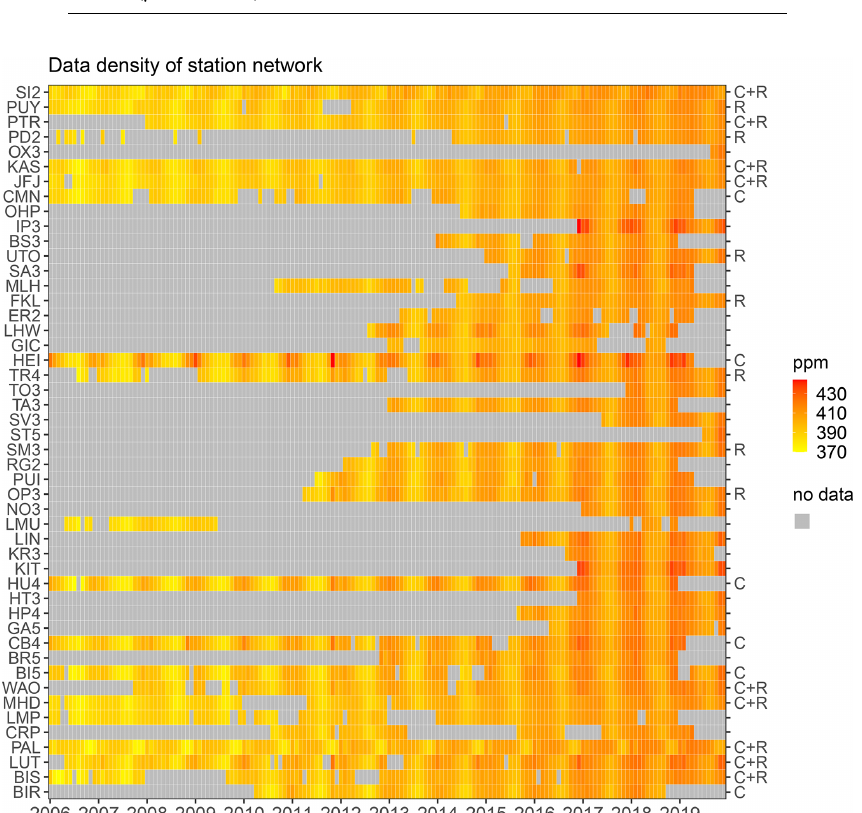
Figure 2. Dataset density measured from 2006 until 2019 over Europe. Yellow to red colour scale denotes monthly-averaged dry mole fractions of CO 2 . Symbols on the right-hand axis: C – core site; R – recent